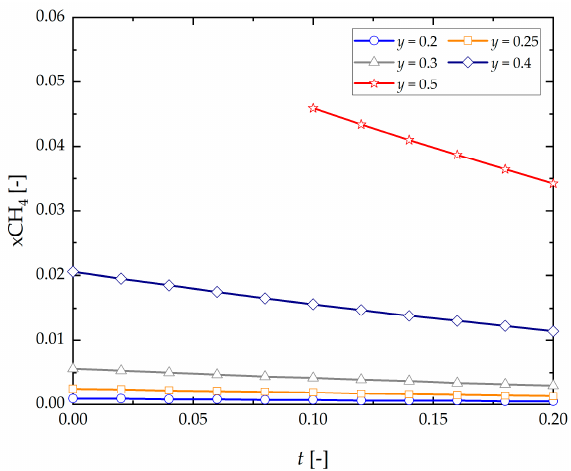
= 𝑓(𝑡,𝑦) with y = const, of the reforming process = f ( t , y ) with y = const, of the reforming process (cid:3120) 4